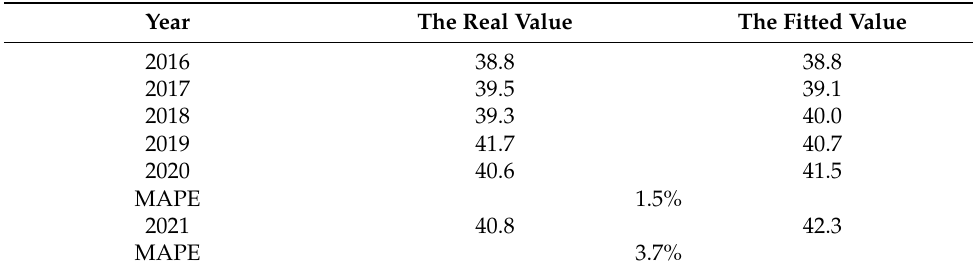
Table 7. The fitted value and the real value of water requirement.